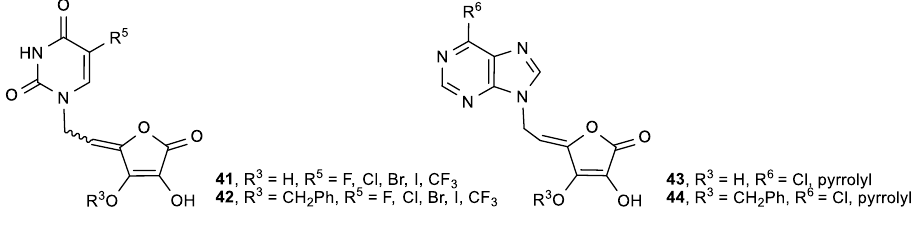
Figure 19. Pyrimidine and purine derivatives of ASA. Table 16. The antitumor activities of the pyrimidine and purine derivatives of ASA.